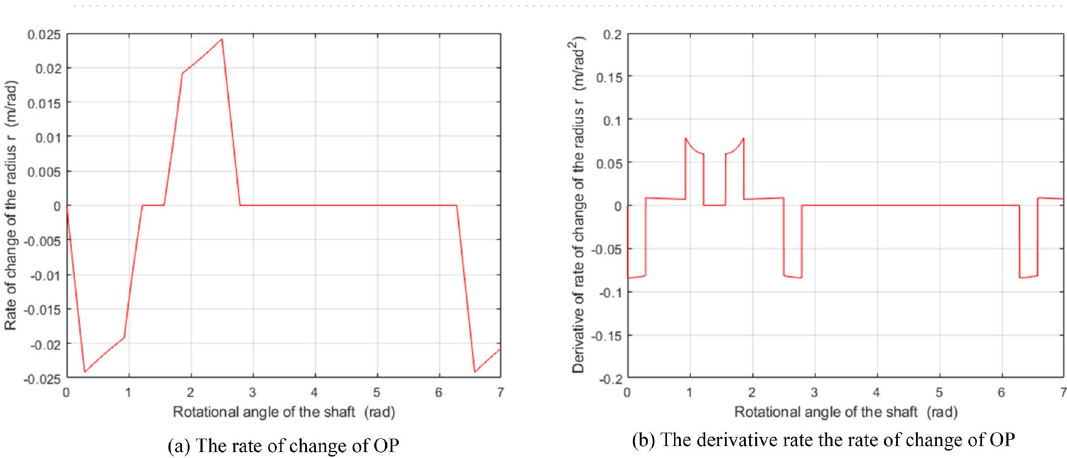
Figure 7. The change rate of the length OP and its derivative to the angle of the rotor shaft. (Matlab2019a. https:// ww2. mathw orks. cn/ produ cts/ get- matlab. html?s_ tid= gn_ getml).